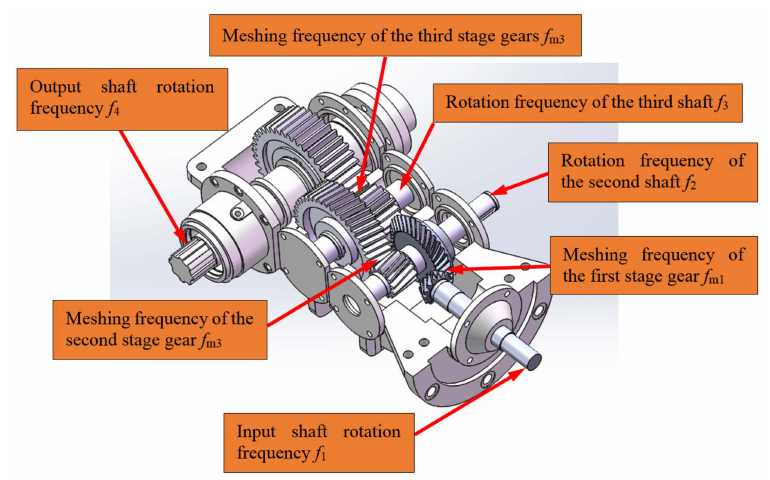
Figure 5. Three gear transmissions in the gear reducer. Table 4. Gear parameters in the gear